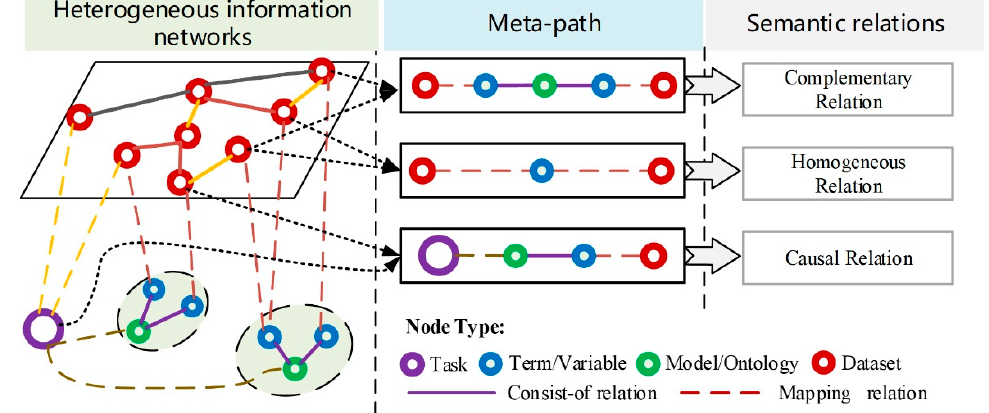
Figure 3. Relationship discovery based on heterogeneous information networks (HINs).